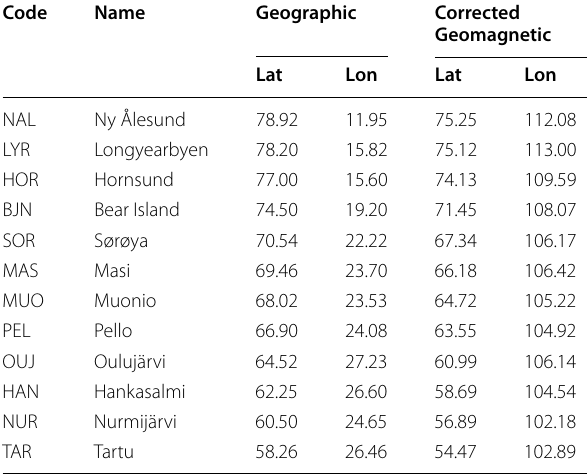
Table 3 IMAGE magnetometer chain stations Code Name Geographic Corrected